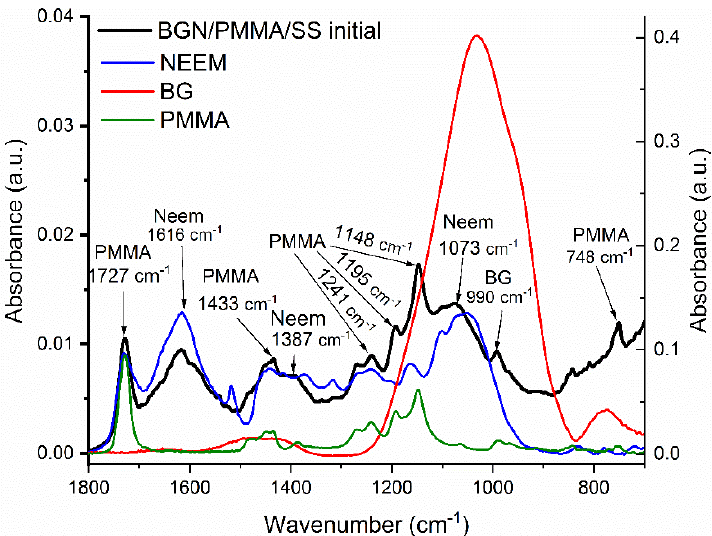
Figure 2. FTIR spectrum of BGN/PMMA/stainless steel (SS) film deposited by matrix-assisted pulsed laser evaporation (MAPLE) and of single components, namely Neem, BG, and PMMA.